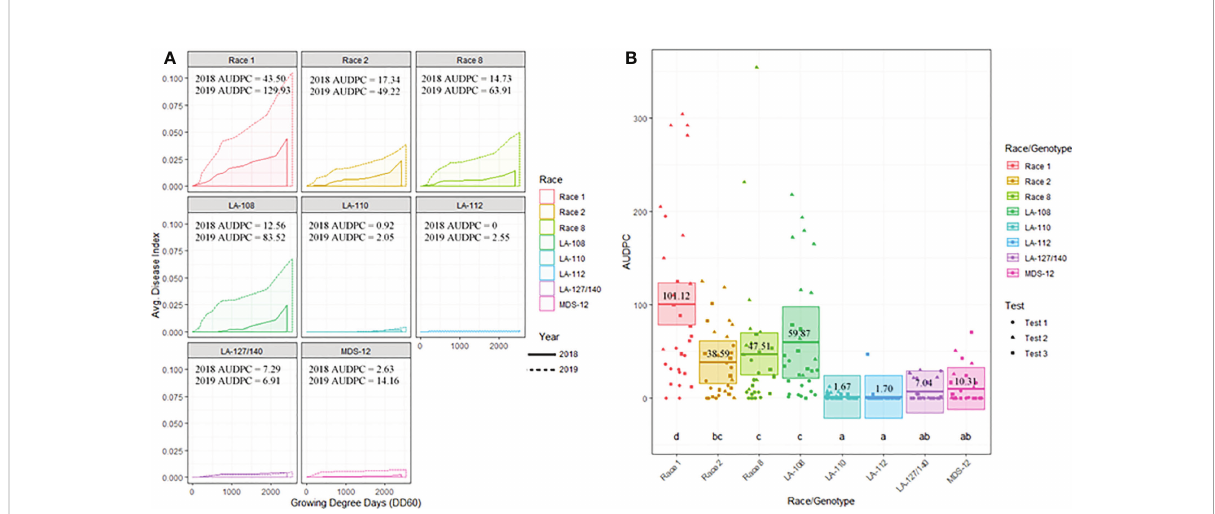
FIGURE 3 (A) Temporal disease progression curves for each race/genotype of FOV collected to show the distribution throughout the cotton seasons depicted as a solid line for 2018 testing and a dashed line for 2019 testing. Area under the disease progress curve (AUDPC) is shaded in a lighter color as indicated by the legend. (B) Box plots with means (indicated by thick horizontal lines) and 95% con fi dence intervals (shaded boxes) of the AUDPC values for each race/genotype of FOV as estimated by a linear mixed effect model shown as an average of all three test. Calculated AUDPC values for individual test plots are marked by symbols corresponding to the test from which they were collected. The mean AUDPC value is listed just above the mean line for each race/genotype of FOV and statistical signi fi cance is indicated by letters below the boxplots. Races/genotypes that share letters do not differ signi fi